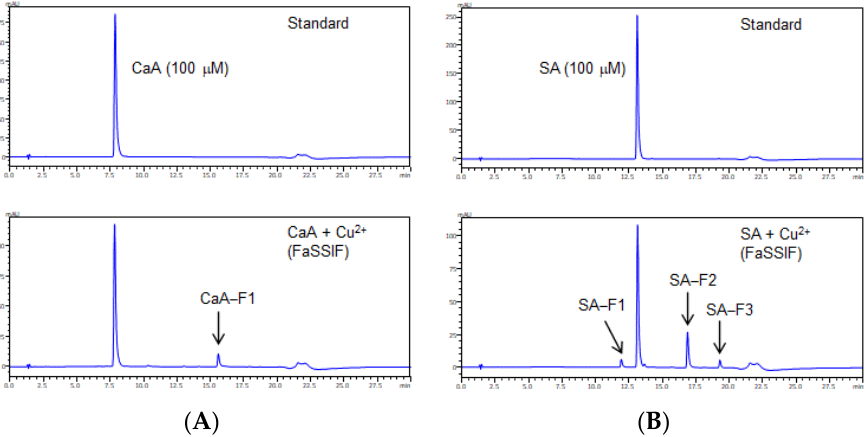
Figure 2. Chromatograms of ( A ) CaA and ( B ) SA with copper ion in FaSSIF after 60 min of reaction. The analysis of CaA and SA for was performed at 320 nm.